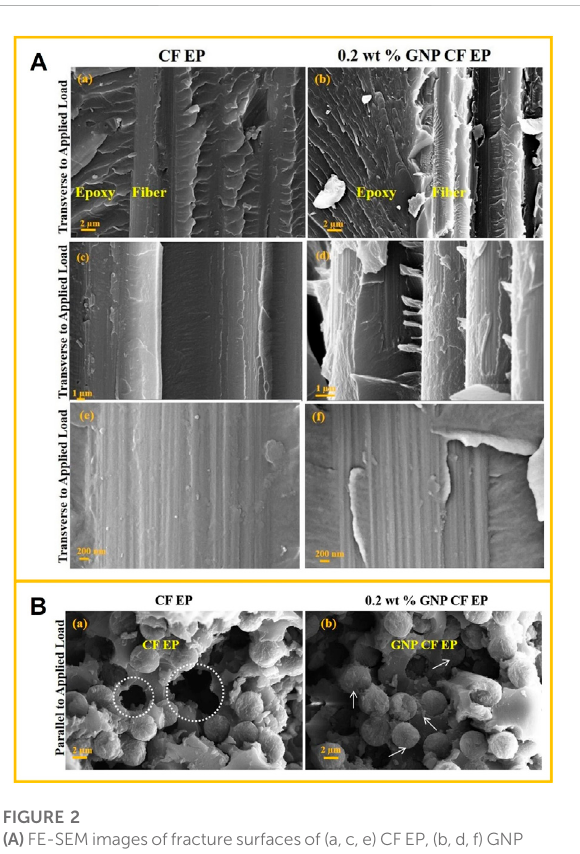
FIGURE 2 (A) FE-SEMimagesoffracturesurfacesof(a,c,e)CFEP,(b,d,f)GNP CF EP, in the transverse direction to applied tensile load. Reprinted with permission from (Jain et al., 2021). Copyright 2021 Springer Nature. (B) FE-SEM images of fracture surfaces of (a) CF EP and (b) GNP CF EP in the direction parallel to the applied load. Reprinted with permission from (Jain et al., 2021). Copyright 2021 Springer